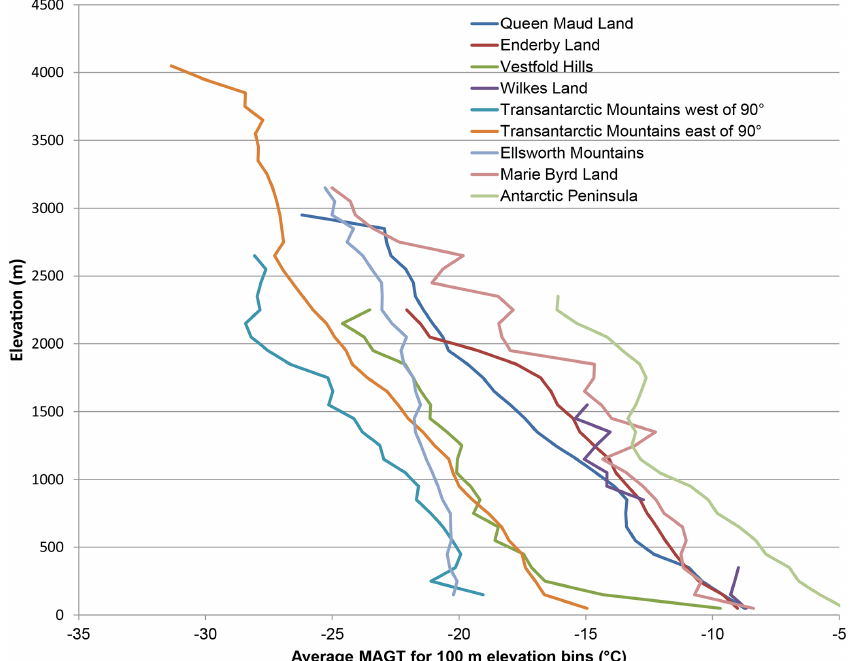
Figure 16. Altitudinal MAGT gradients for Antarctic soil regions calculated for 100m elevation